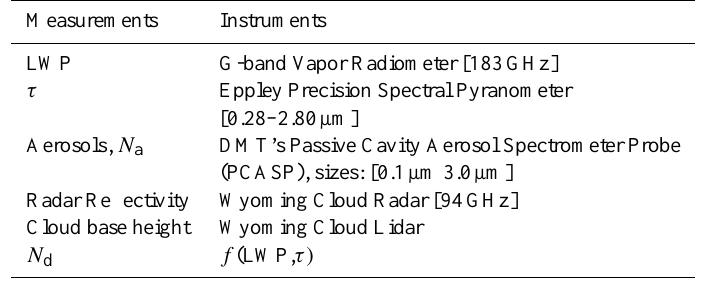
Table 3. Variables and instrument dependences.